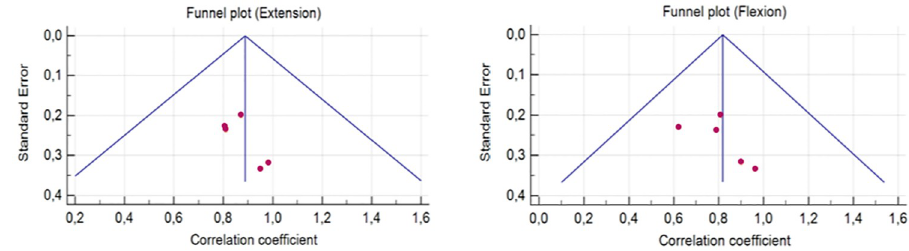
Fig 3. Funnel plot of extension and